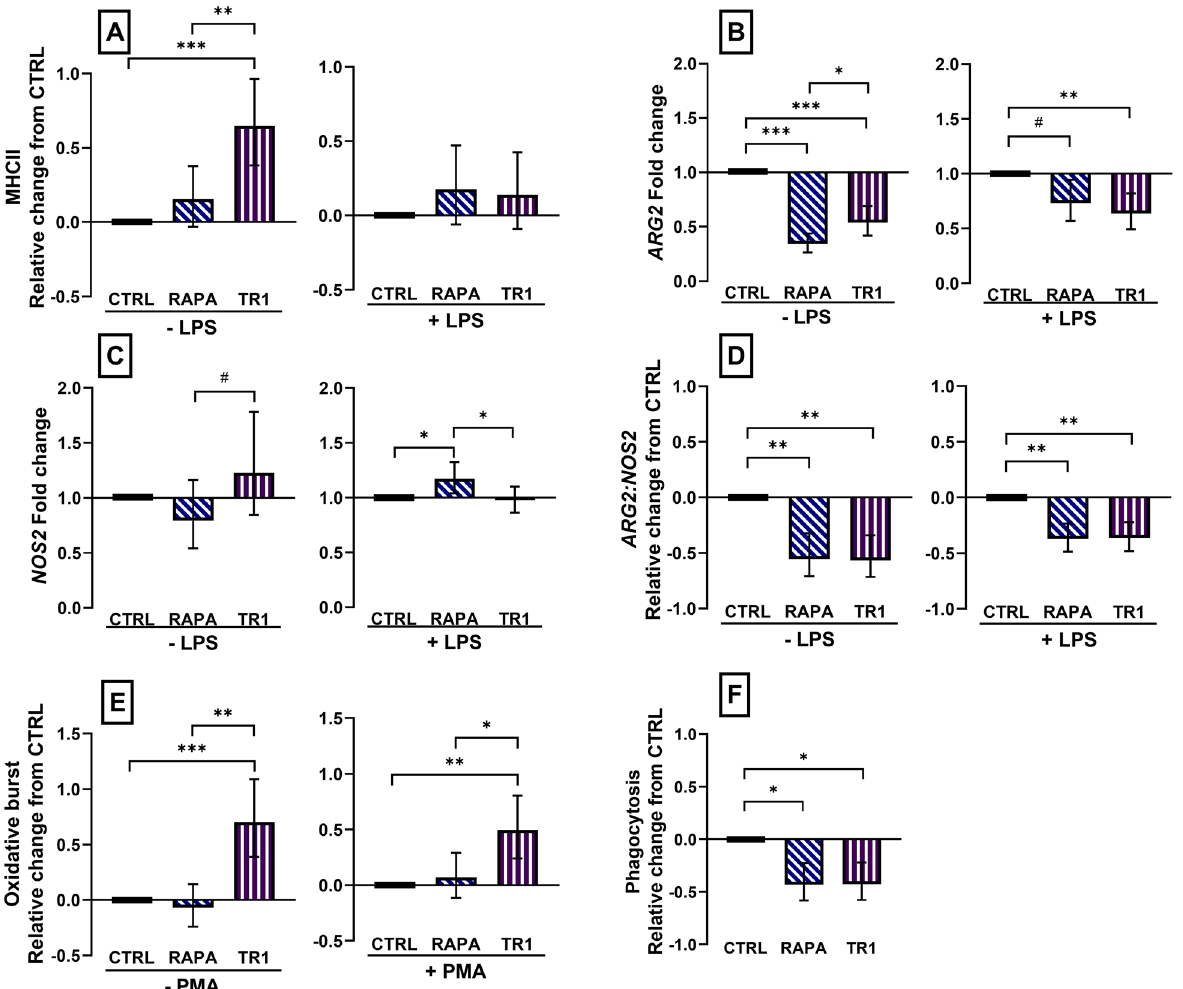
Figure 1. Changes in surface maker expression, mRNA abundance, oxidative burst, and phagocytosis in M1 macrophages polarized for 3 days with 10 ng/mL IFNG and 20 ng/mL CSF2 and concurrently treated with vehicle (CTRL), or inhibitors rapamycin (RAPA) or Torin-1 (T1) at 100 nM. Cells were incubated with vehicle (− LPS) or stimulated with 100 nM LPS (+LPS) for 16 h to measure change in MHCII expression ( A ), or 4 h to measure changes in mRNA abundance of arginase 2 ( ARG2, B ) and inducible nitric oxide synthase ( NOS2, C ) as well as their ratio ( D ). Cells were incubated with 10 µM H 2 DCFDA fluorescein loading dye for 15 min and stimulated with phorbol myristate acetate (PMA) at 0 (− PMA), or 25 (+ PMA) ng/mL for 15 min to measure oxidative burst ( E ) or with pHrodo bioparticles for 1 h to measure cellular phagocytosis ( F ). Data were expressed relative to CTRL and presented as the relative change from CTRL in unstimulated and stimulated cells for MHCII, ARG2:NOS2 , phagocytosis, and oxidative burst. mRNA abundance was expressed as the fold change from CTRL in unstimulated and stimulated cells. Data from cell isolation of 12 cows are presented as the geometric mean and backtransformed 95% confidence interval. ANOVA tests between CTRL and inhibitors, and between inhibitors are presented with Bonferroni-adjustment for multiple comparisons: P ≤ 0.10 ( # ), P ≤ 0.05 (*), P ≤ 0.01 (**), P ≤ 0.0001 Unlike the opposing effects that mTOR inhibition had on M1, expression of IL12A and IL12B was only affected by Torin-1 in M2 MPh. Expression of IL12A was decreased ( P < 0.0001) in Torin-1-treated unstimulated and LPS-stimulated M2 whereas LPS-stimulated Torin-1-treated M2 cells had decreased ( P = 0.0009) IL12B (Fig. 4A, B). Expression of IL1B was decreased ( P < 0.0001) in both unstimulated and stimulated Torin-1-treated Torin-1 increased IL6 ( P = 0.09) in unstimulated M2 cells whereas it decreased IL6 ( P = 0.03) in LPS-stimulated cells (Fig. 4D). Concentration of IL10 was decreased ( P < 0.001) in cell culture supernatant from unstimulated and stimulated cells that were treated with Torin-1 during polarization, and to a smaller degree in LPS-stimulated cells treated with RAPA ( P < 0.0001) (Fig. 4E). Concentration of TNF was decreased ( P < 0.0001) in cell culture supernatant from stimulated cells that were treated with Torin-1 during polarization (Fig. 4F). Overall, mTOR inhibition during differentiation of M2 MPh resulted in decreased expression of pro-inflammatory cytokines